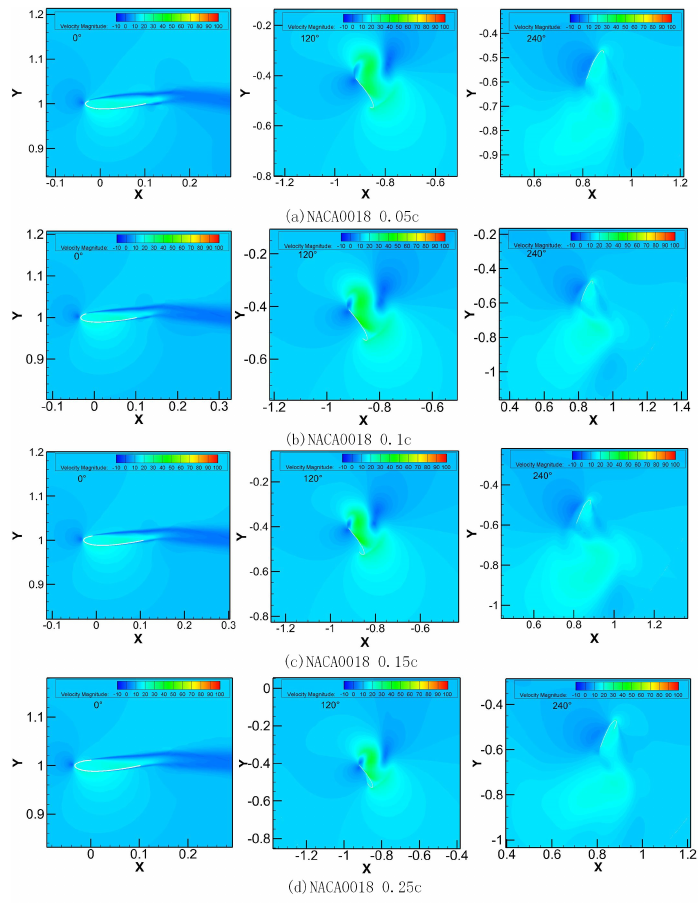
Figure 24. J-shaped blade velocity flow